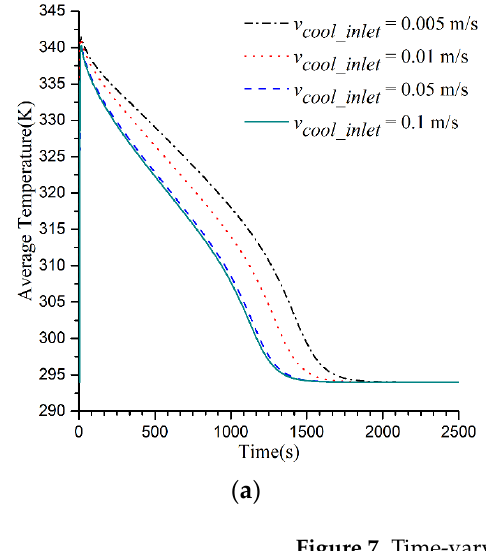
Figure 7. Time-varying curves of average temperature and hydrogen storage percentage by weight in the reaction zone subjected to different cooling water flow rates. ( a ) Average temperature; ( b ) Percentage by weight.